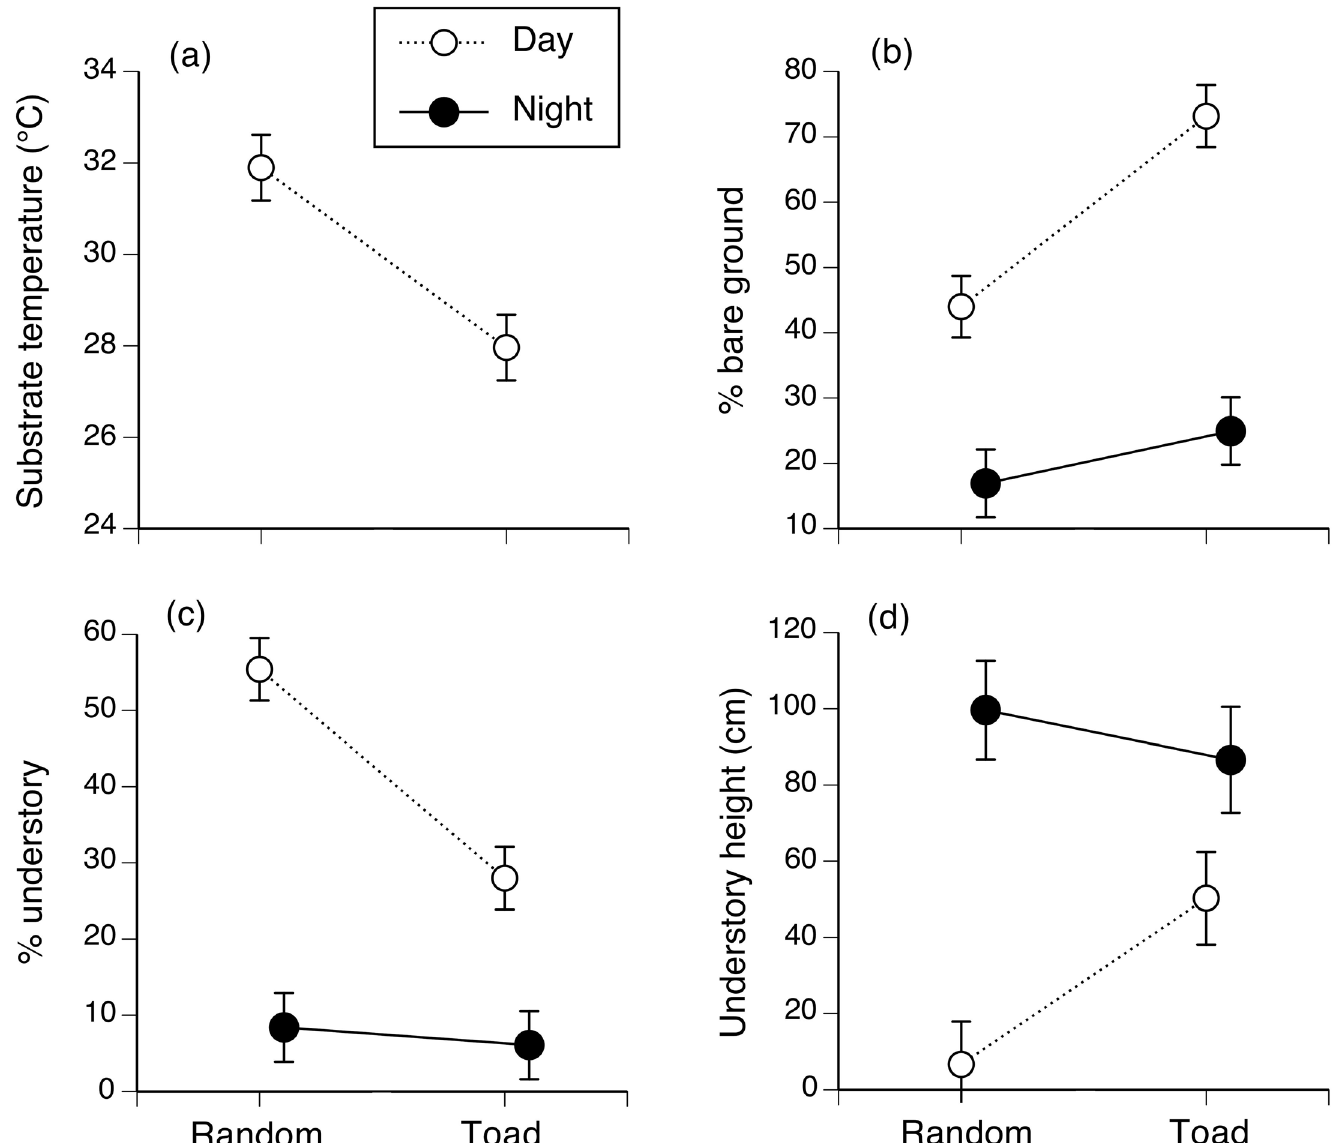
Fig 4. Microhabitat selection by toads on Hawai ’ i. Figure shows microhabitat use of 40 radio-tracked and spool-tracked cane toads on the island of Hawai ’ i. The panels show interactions between time (day vs. night) and toad habitat selection (used places vs. nearby available sites that were not used): (a) substrate temperature, as recorded using an infrared thermometer (recorded only by day); (b) the % of bare ground within a 1-m quadrat surrounding the toad, compared to a randomly-chosen site 5 m away; (c) the % of understory vegetation within a 1-m quadrat surrounding the toad, compared to a randomly- chosen site 5 m away; and (d) the height of understory vegetation within a 1-m quadrat surrounding the toad, compared to a randomly-chosen site 5 m away. Figure shows mean values and associated standard